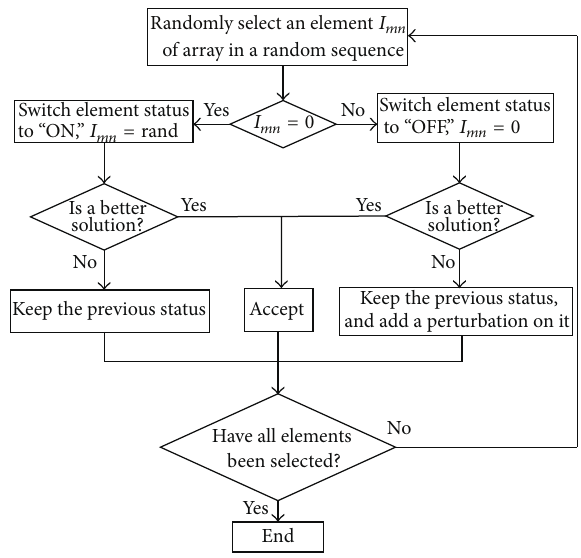
Figure 2: Flow chart of state transition search